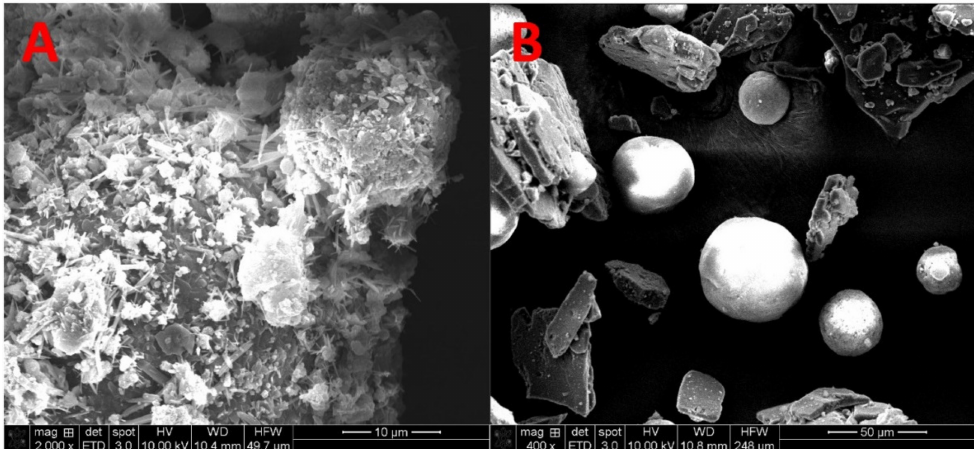
Figure 1. Scanning Electron Microscopy demonstrating the particle size of the drug in ( A ) PFS and ( B )